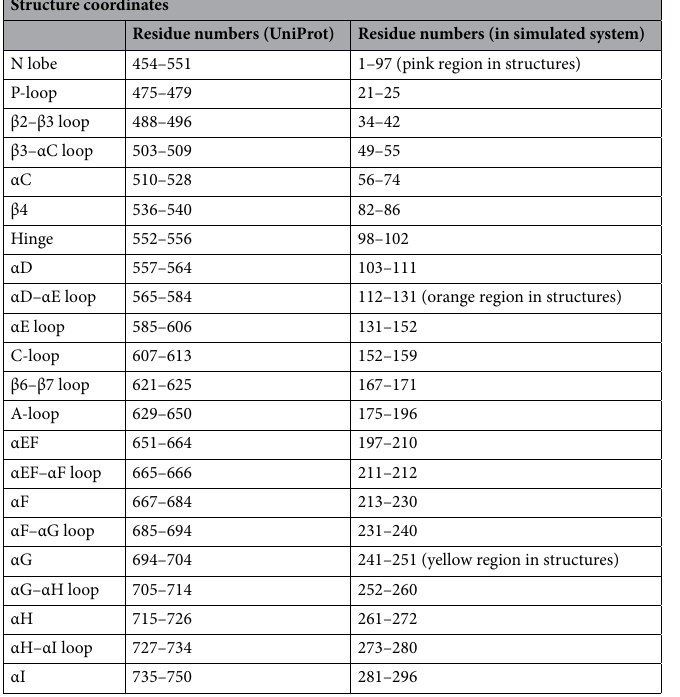
Table 1. The structure coordinates of